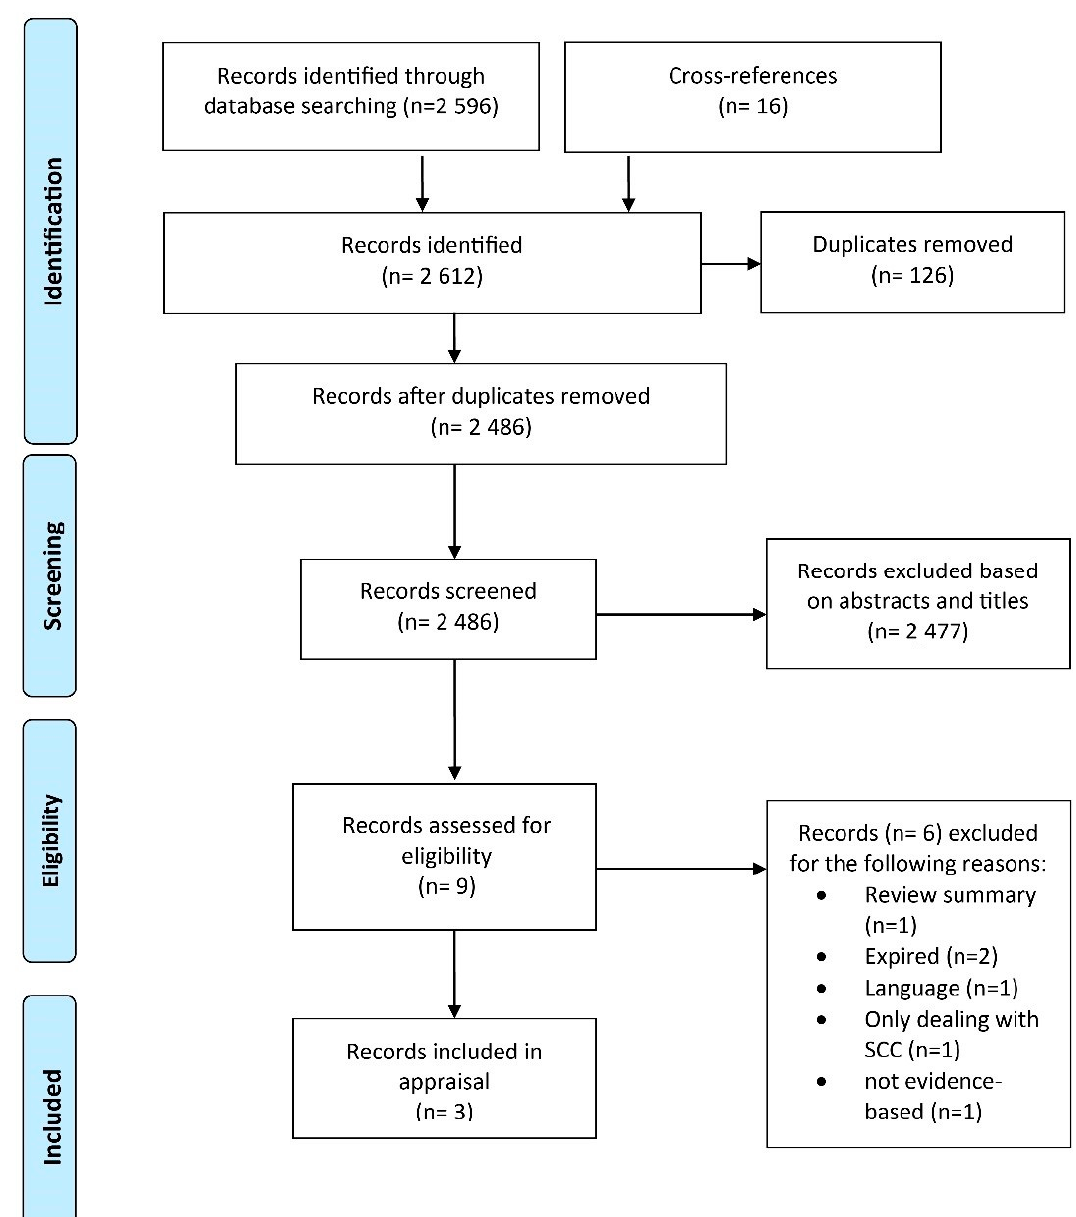
Figure 1. Flow chart of the guideline identification process according to the Preferred Reporting Items for Systematic Reviews and Meta-Analyses (PRISMA)